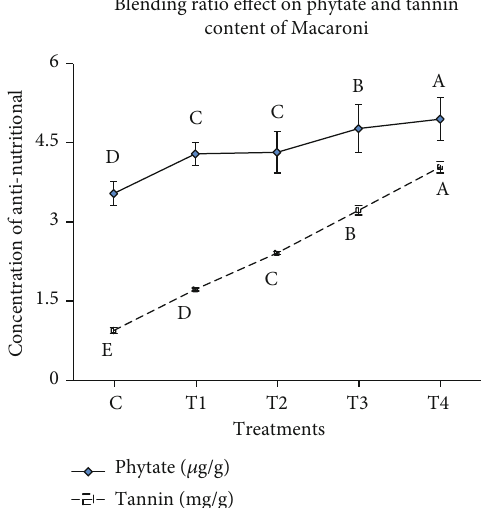
Figure 1: E ff ect of blending ratio on antinutritional content of wheat-moringa-based noodles.